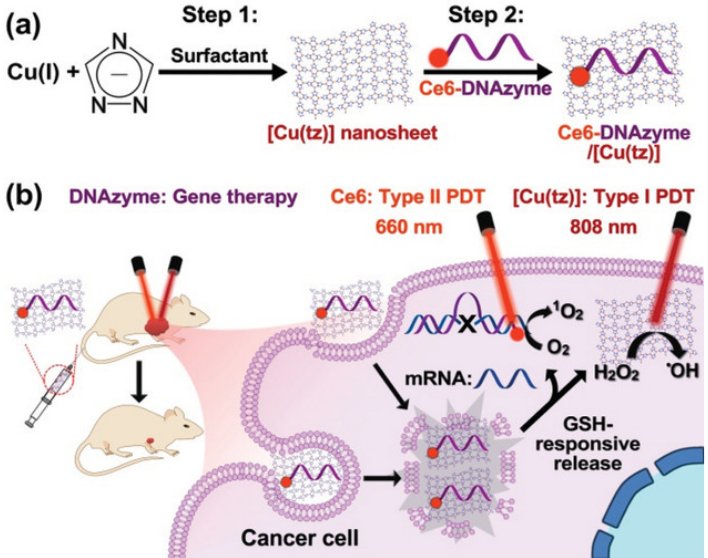
Figure 6. ( a ) Preparation of 2D [Cu(tz)] nanosheets and the Ce6-DNA-zyme/[Cu(tz)] therapeutic platform. ( b ) Schematic illustration of the proposed combination therapy of DNAzyme-based gene silencing, Ce6-based type II PDT, and [Cu(tz)]-nanosheet-based type I PDT. Reprinted with permission from Ref. [173]. 2021, John Wiley and Sons.